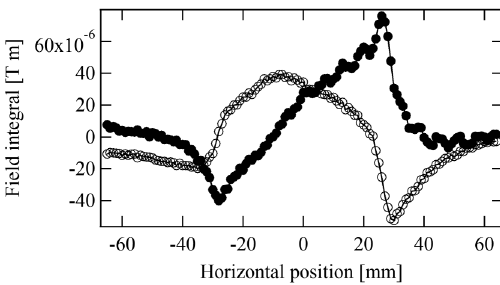
FIG. 8. Averaged measured field integrals h I x i ( (cid:8) ) and h I z i (cid:7) ) with rotating coil. (